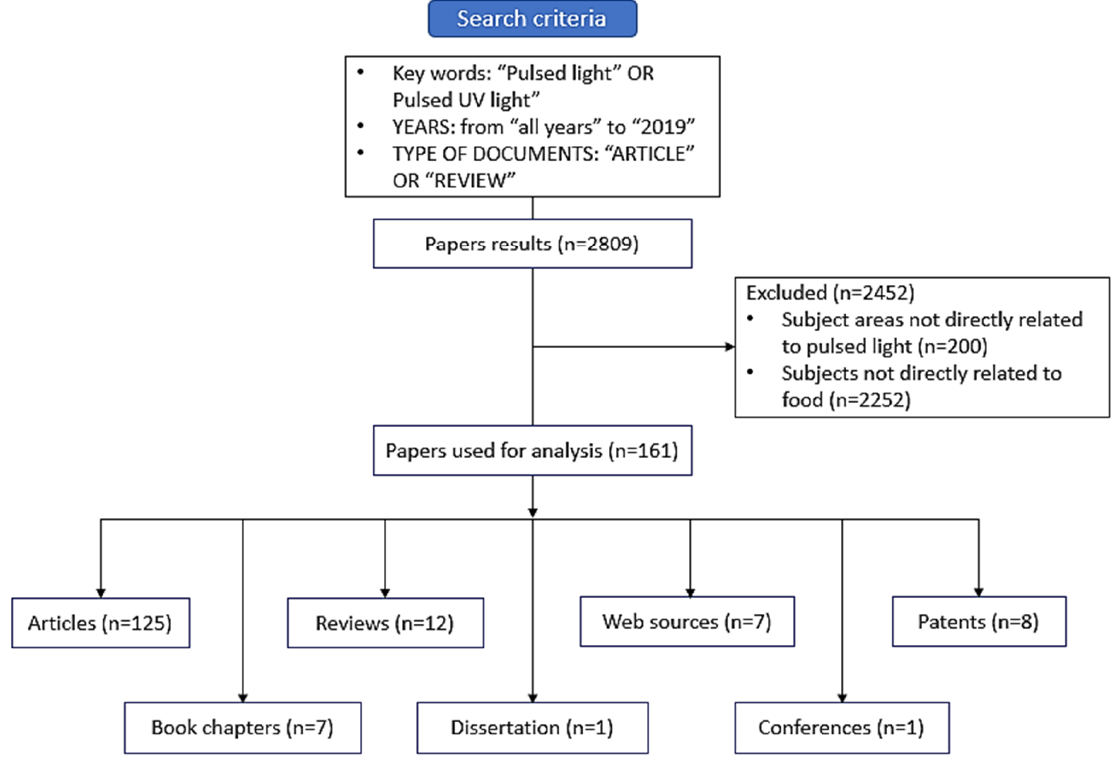
Figure 2. Search criteria for conduction of literature search with keywords “pulsed light”, “pulsed UV light” and excluding results not related to the food applications. For the review, 161 articles were referred. Table 1. Previously published review papers on PL processing.